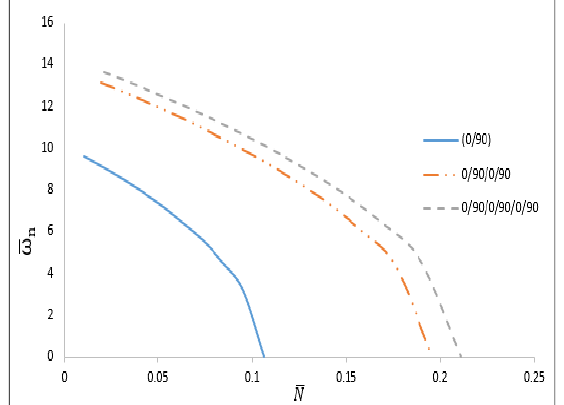
Fig. 4. Natural frequency with ratio of buckling load for different layers of simply supported square plate (a/h=10),